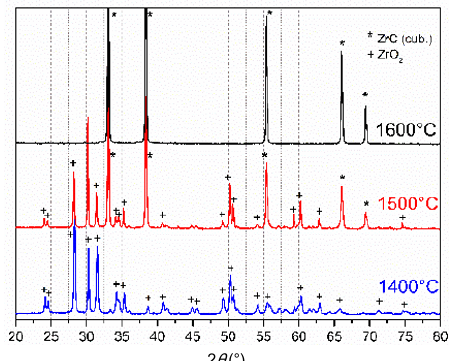
Fig. 1 XRD patterns of ZrO 2 and carbon black powder mixture in the molar ratio of 1:3.00 after synthesis process with synthesis temperature. Fig. 2 Process flow of ZrC